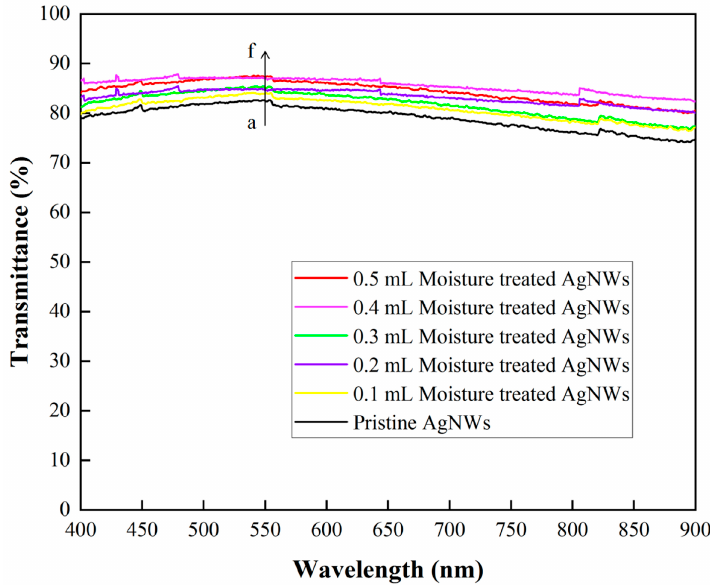
Figure 10. Increase of water moisture quantity and light transmission performance in visible light range.